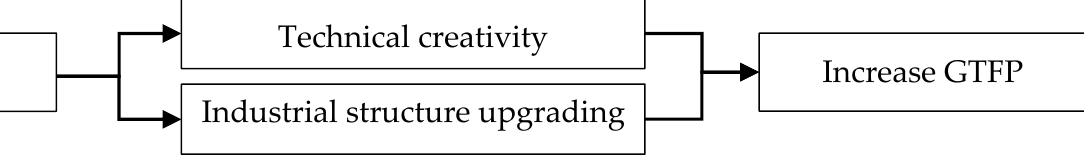
Figure 2. The mechanism of the EPI on GTFP.